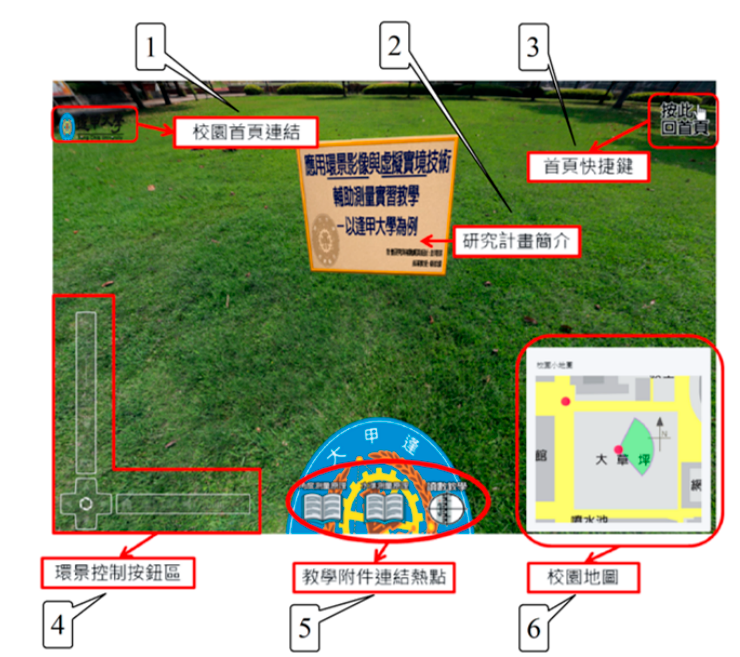
Figure 10. Homepage of the developed platform. Symbol 1: hyperlink to the FCU official webpage; symbol 2: information of the supporting project; symbol 3: back to the homepage control bar; symbol 4: control bars (zoom in, zoom out, or switch the image to VR mode); symbol 5: hyperlink to the related documents; symbol 6: quick map.